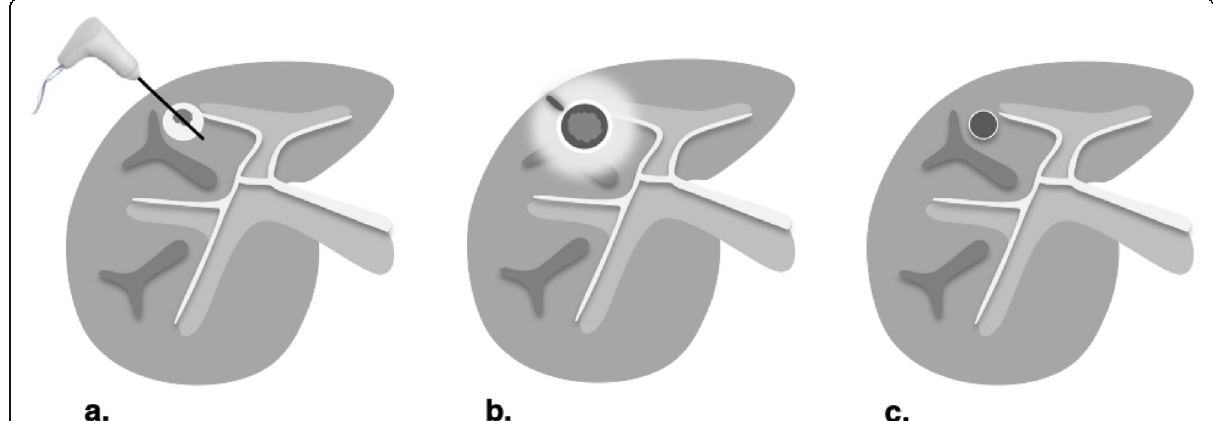
Fig. 7 Expected treatment response after percutaneous ethanol ablation (PEA), radiofrequency ablation (RFA) and microwave ablation (MWA). Axial contrast-enhanced CT images of the liver obtained in late arterial phase are illustrated: a Pretreatment: RFA is used with curative intent of early-stage hepatocellular carcinoma ( ≤ 3 cm) in non-surgical patients. PEA is typically used when RFA is unsafe or contraindicated. MWA may target larger tumor with curative intent but additional studies are needed. Larger tumor (> 3 cm) may be targeted for downstaging purpose or as a bridging therapy prior to transplantation alone or in combination with other treatments. b 1 – 3 months posttreatment: Diameter of ablation zone at the time of treatment is usually 5 to 10 mm greater than the treated lesion. The following features may be seen: intratumoral gas foci up to 1 month posttreatment, thin linear peripheral enhancement along ablation zone, smooth rind or wedge-shaped parenchymal enhancement around ablation zone, intralesional hyperdensity/intensity on unenhanced CT or on T1-weighted MRI (reflecting coagulation necrosis), and hypodense liver parenchyma may be seen along needle trajectory. c ≥ 6 months posttreatment: ablation zone involutes over time. Thin linear